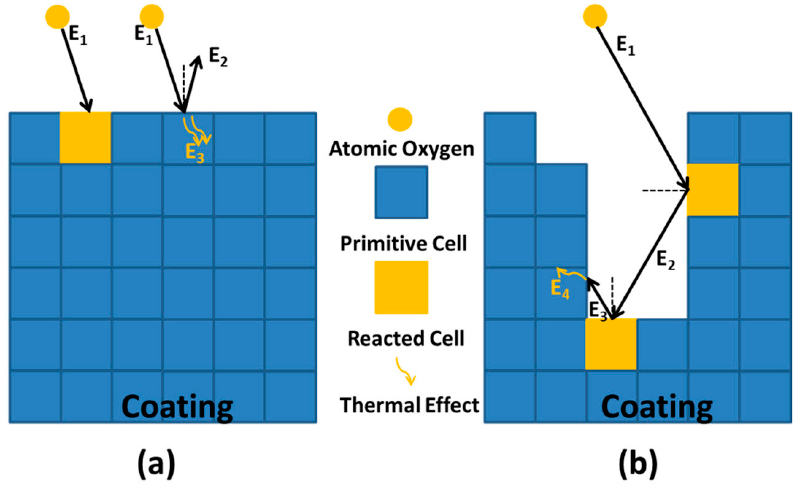
Figure 10. Schematics for mechanism of the atomic oxygen attacking the siloxane coating materials ( a ) without cracks and ( b ) with cracks. ( a ) without cracks and ( b ) with